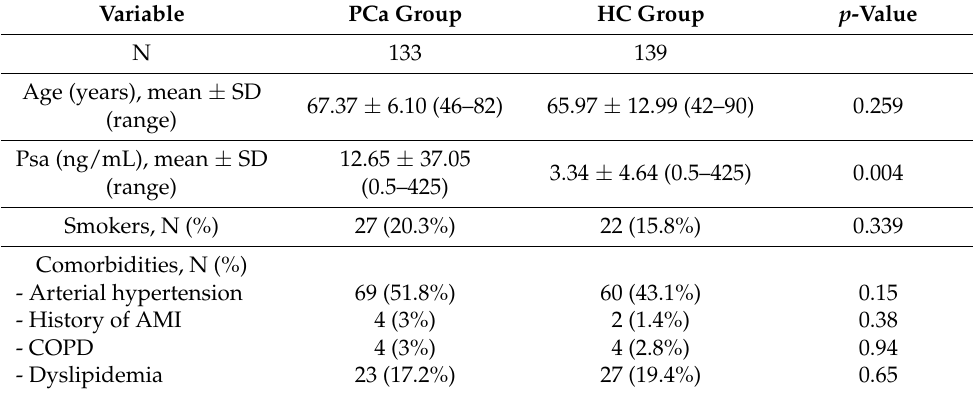
Table 1. Baseline characteristics of the study population.